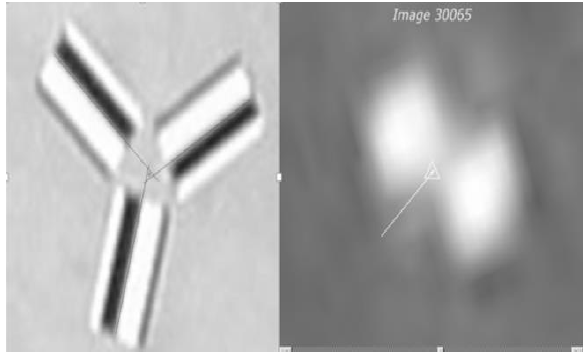
Figure 2. Schematic diagram of improving the image point accuracy in